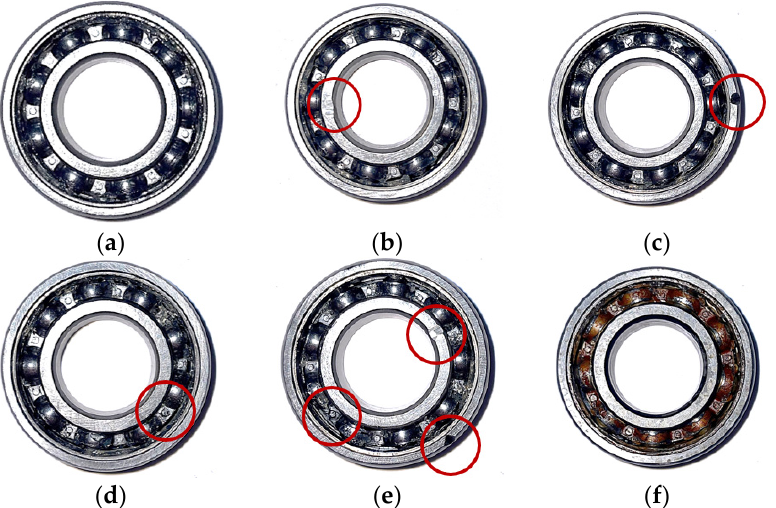
Figure 8. Studied bearings with different damages: ( a ) healthy bearing, ( b ) bearing with damaged inner ring, ( c ) damaged outer ring, ( d ) damaged cage, ( e ) complex damage, and ( f ) material fatigue.